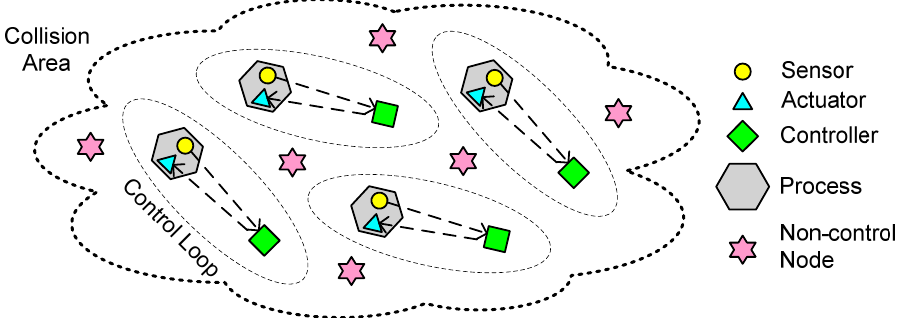
Figure 1. Network topology of multiple control loops within a collision area.